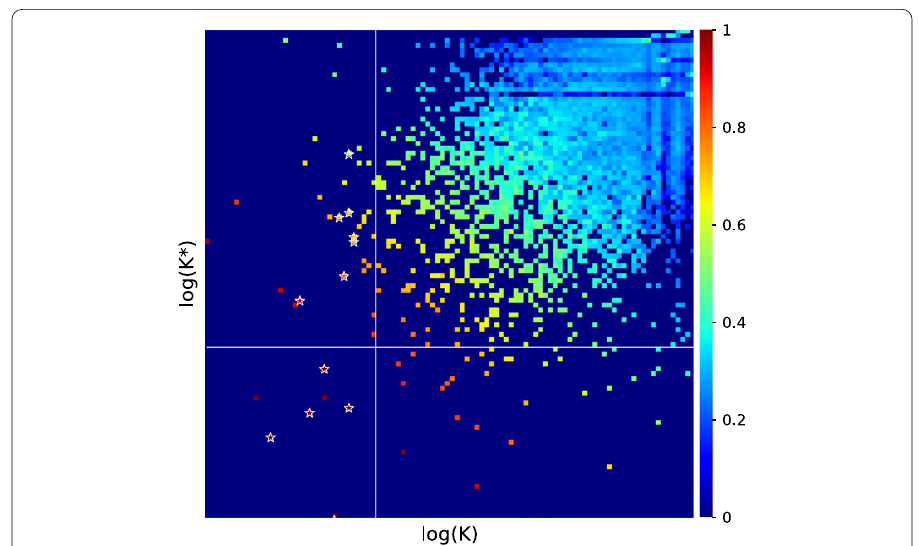
Fig. 2 Density of nodes of the MetaCore network on the PageRank-CheiRank ( K , K ∗ ) -plane. The numbers of the color bar are a linear function of the logarithm of the density (with maximum values corresponding to 1 (red); minimum non-zero and zero values of the density corresponding to 0 (blue); the distribution is computed for 100 × 100 cells equidistant in logarithmic scale). The white stars indicate the positions of the 12 selected nodes presented in Table 1. The white vertical and horizontal lines represent nodes with K ≤ 40 and K ∗ ≤ 40 ,